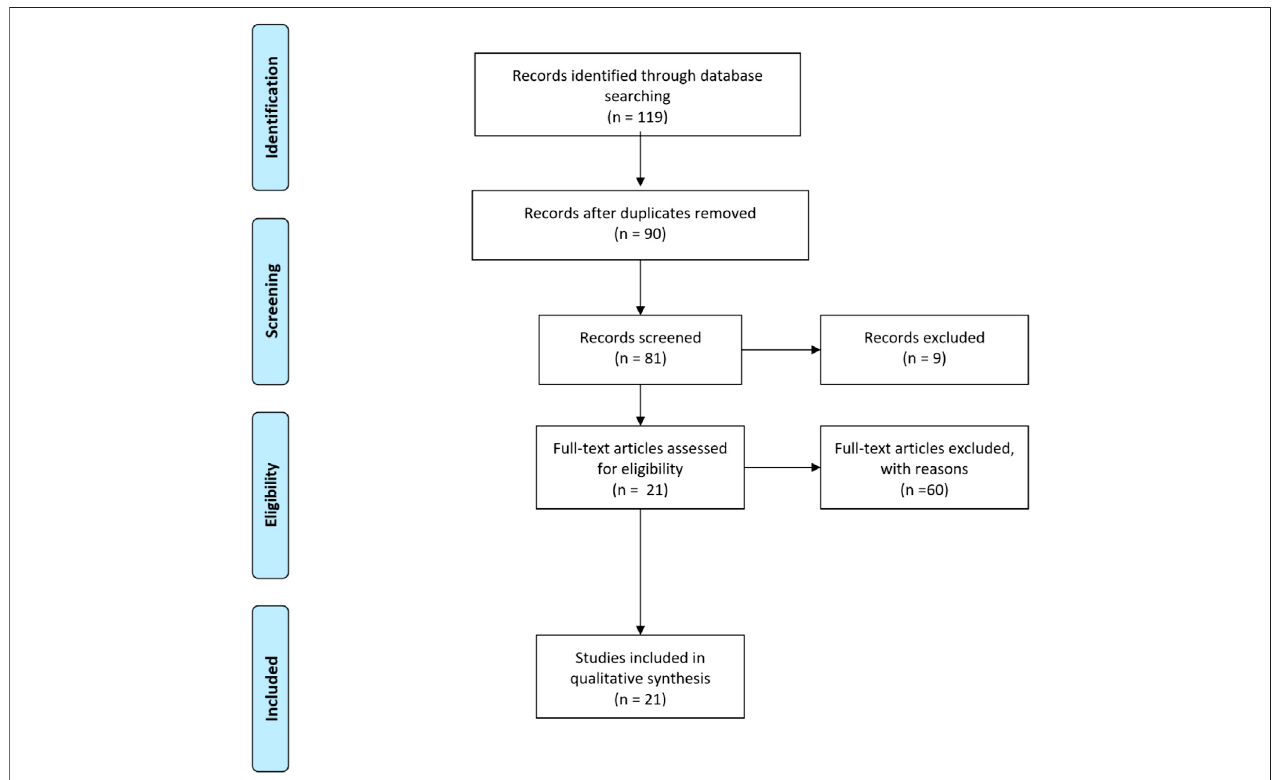
FIGURE 2 | PRISMA fl ow diagram for this review ’ s search process (Moher et al.,